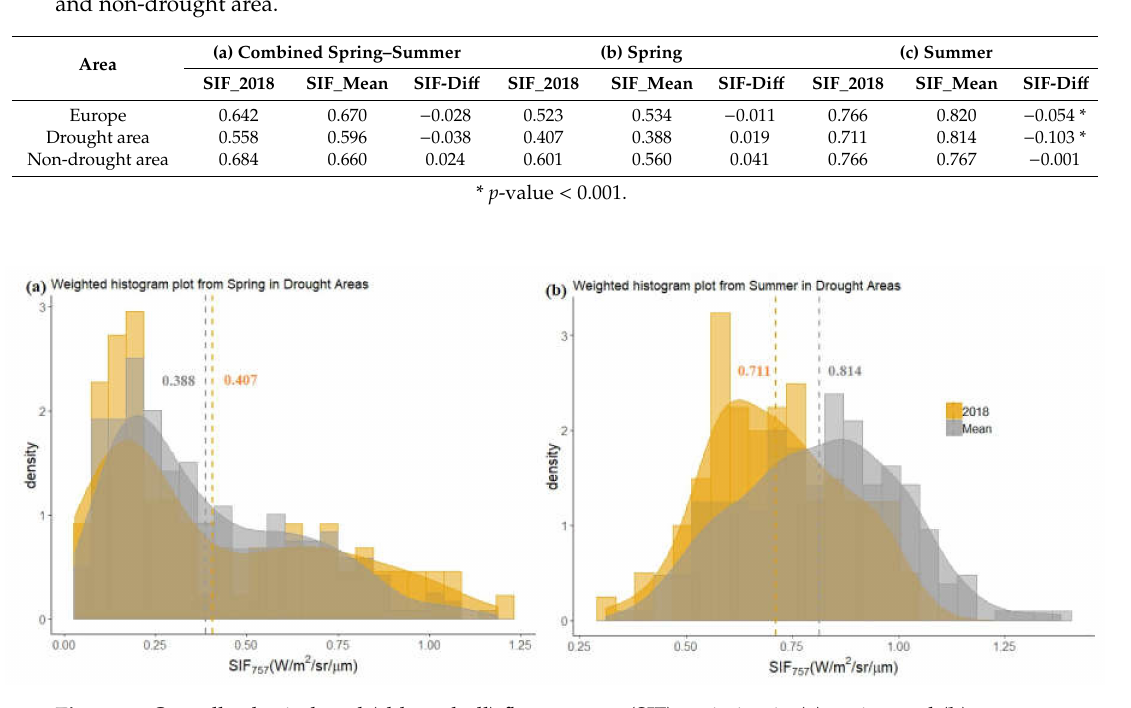
Figure 2. Overall solar-induced (chlorophyll) fluorescence (SIF) variation in ( a ) spring and ( b ) summer season for drought areas in 2018 (SIF_2018, in orange) compared to mean SIF values from 2015–2017 (SIF_Mean, in grey). Bars indicate the histogram of the SIF, whereas curves represent the density plot of the